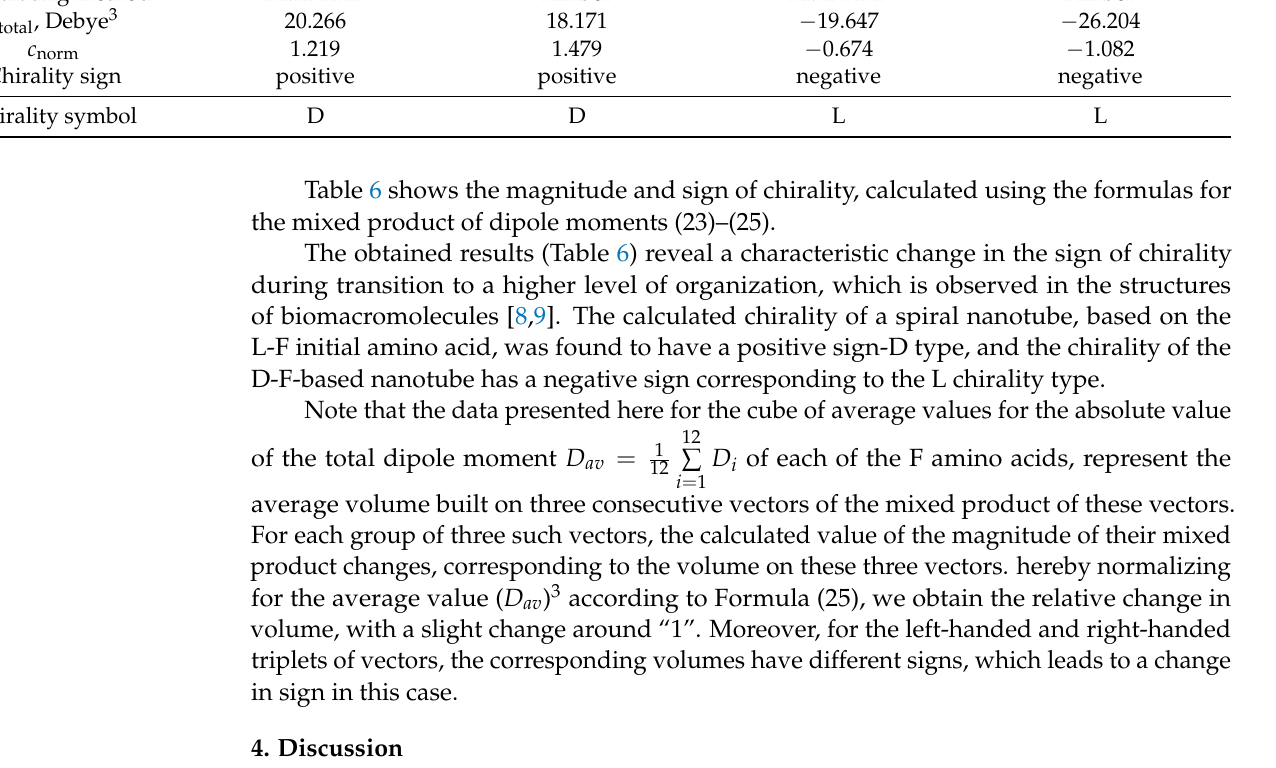
Table 6. Magnitudes and signs of the chirality obtained for L-F and D-F PNTs for various calculating methods. Type of